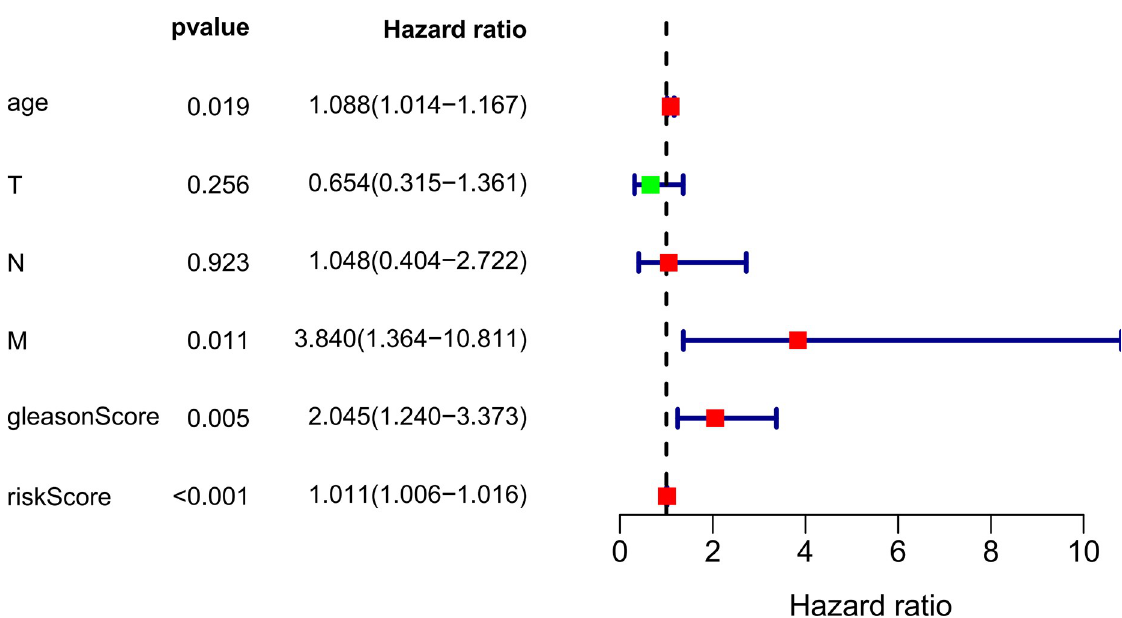
Fig 11. The results of ICGC multivariate analysis showed that 4-lncRNA characteristics could be used as an effective predictor of PCa OS rate for other clinicopathological factors.